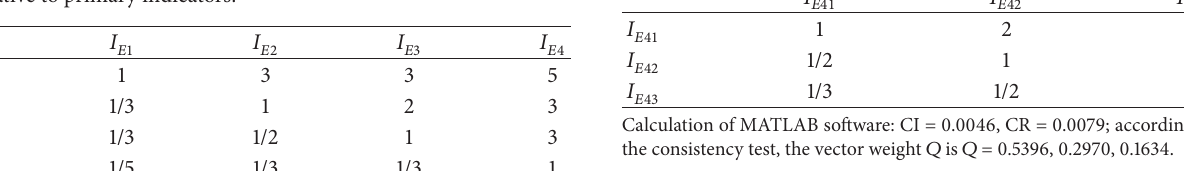
Table 7: Enterprise index judgment matrix of secondary indicators relative to primary indicators.